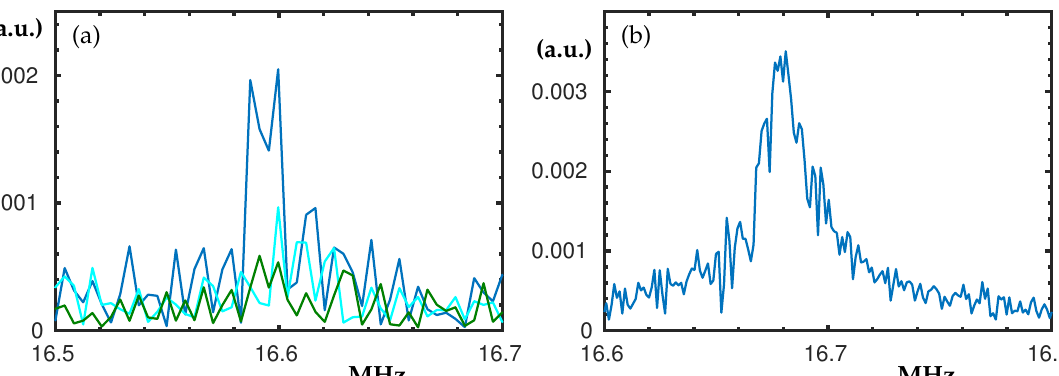
Figure A1. Experimental frequency swipes centred at about 16.6 MHz for V pp = 18 V. In panel ( a ) the blue, cyan and green curves denote V of f = 0 V, V of f = 3 V and V of f = 5 V, respectively. In panel ( b ) the blue curve denote swipe down for V pp = 18 V, V of f = 0 V.